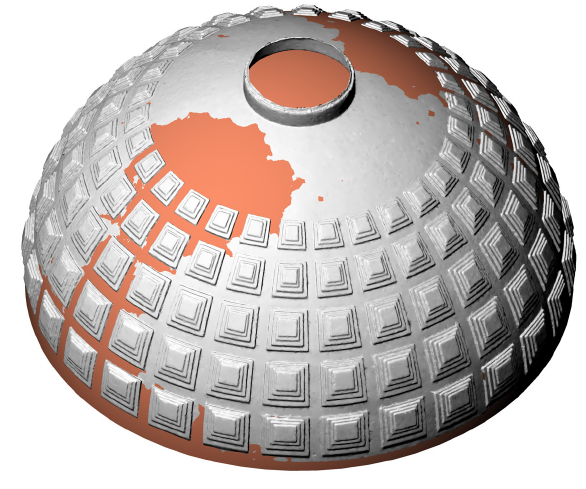
Figure 8. Comparison between the ideal model and the mesh surface extracted from the point cloud. Axonometric